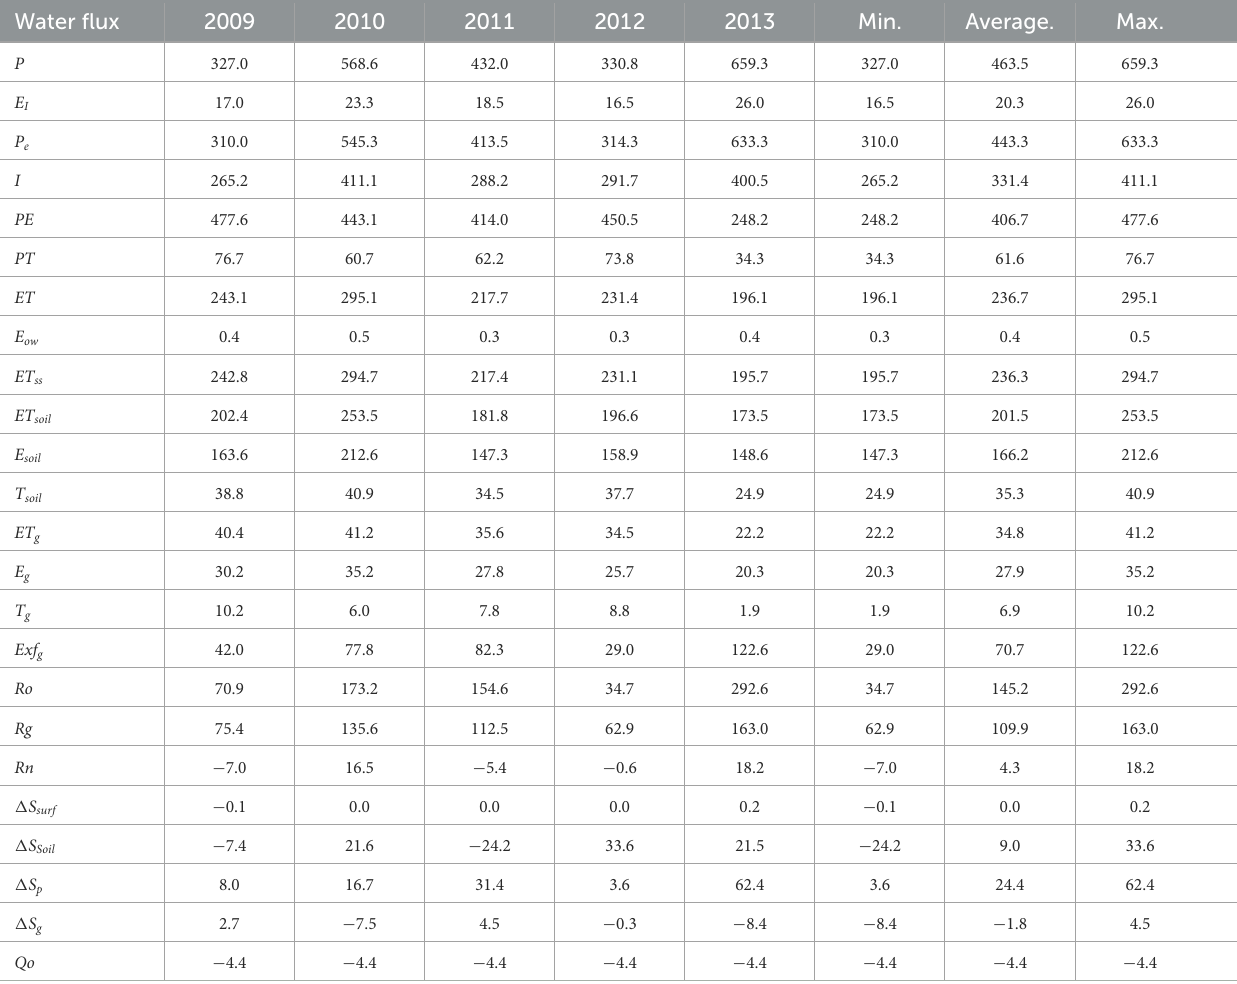
TABLE 3 Water balance components in mm per hydrological year (a hydrological year starts from the 1 st of October of the previous year and ends on the 30 th of September of the specified year). Water